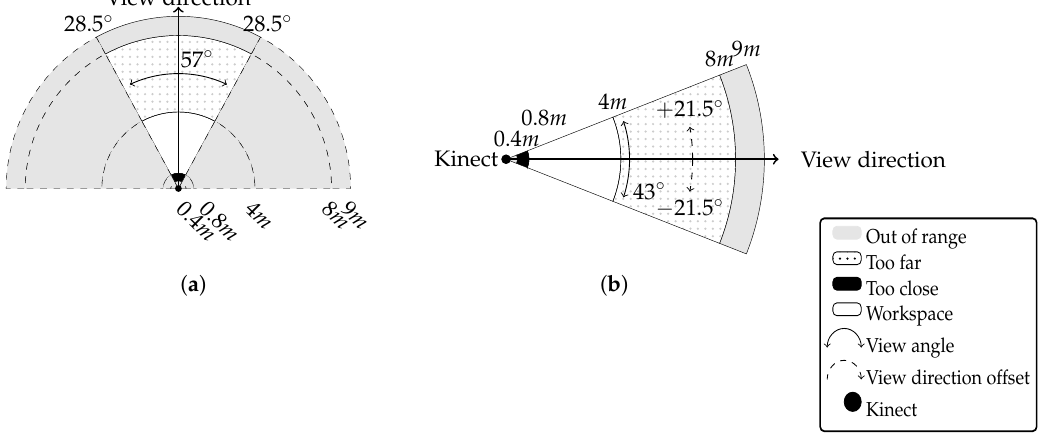
Figure 1. Microsoft Kinect v.1 operating range diagram in horizontal ( a ) and vertical ( b )